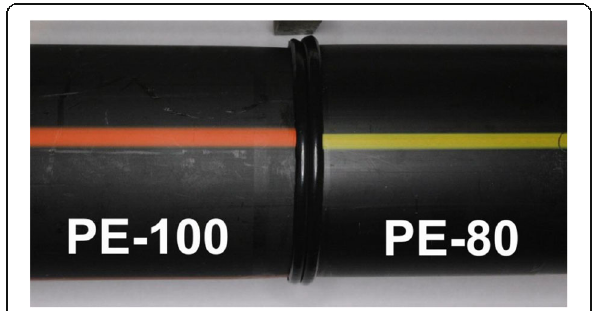
Fig. 1 Welded joint of PE-80 and PE-100 polyethylene pipe types